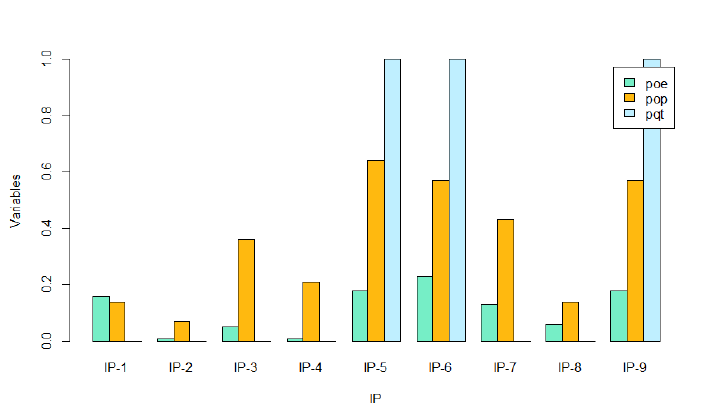
Figure 8. Variable IPs. When the pqt variable is present in an IP, the poe and pop variables tend to increase as Shodan reveals more information. The IPs with high levels of sensitive and confidential information are exposed, allowing the collection of a more significant number of environment variables. Therefore, the risk and the probability of occurrence of an event are greater; that is, it is a directly proportional relationship.